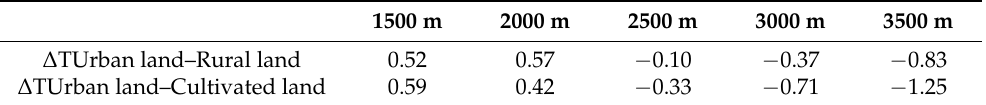
Table 4. Temperature differences between LST (°C) of urban land and other land use types (rural and cultivated land) at different elevations.